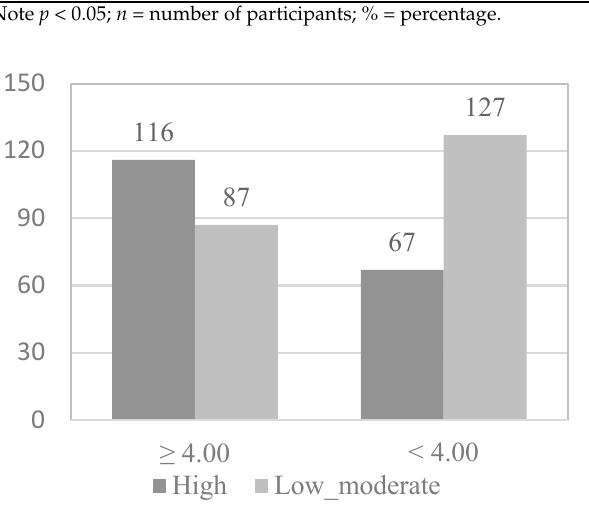
Figure 2. Activity and leisure physical activity level. Figure 3. Gender physical activity level.